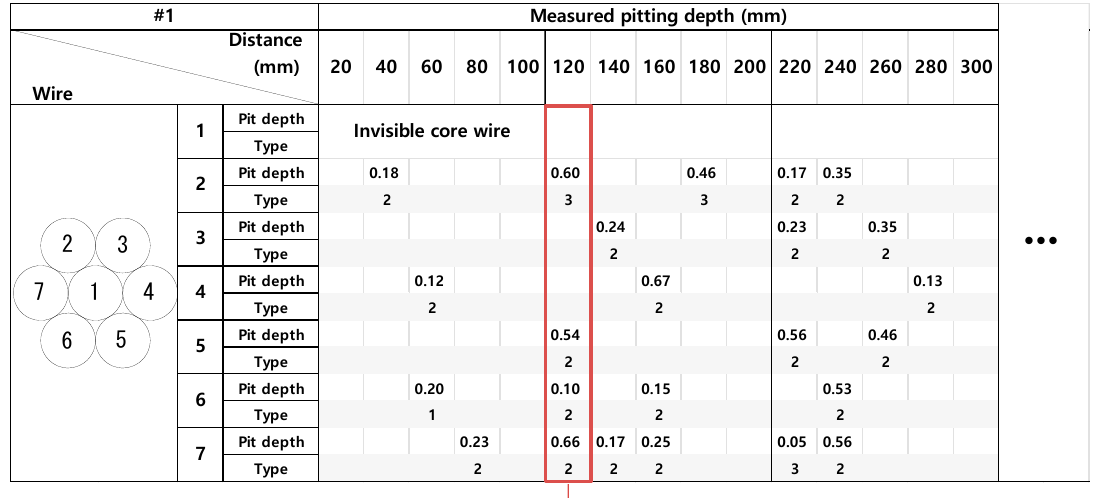
Figure 5. Measured pitting depths of a corroded strand.